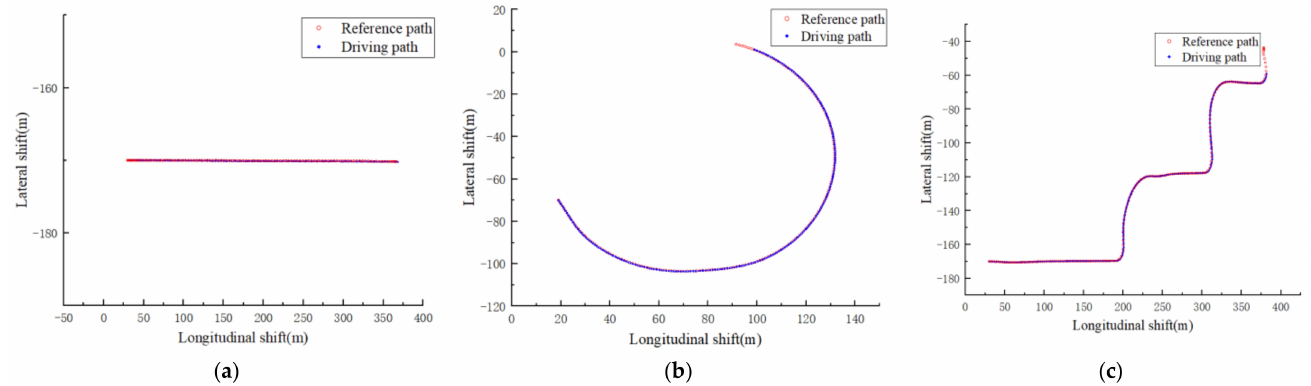
Figure 7. Tracking results in different environments: ( a ) line-tracking global map, ( b ) global map of ramp tracking, and ( c ) global map of complex path